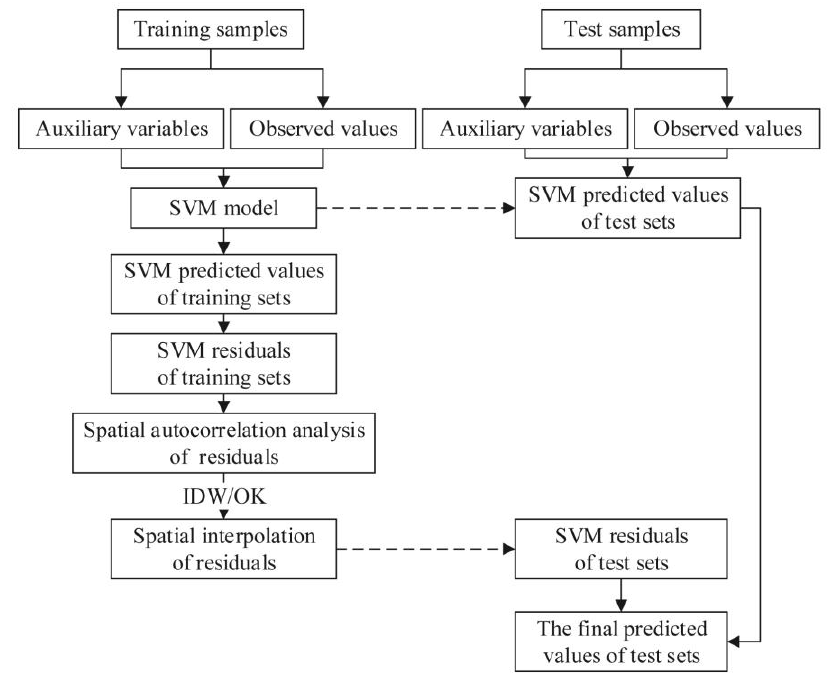
Figure 6. Flowchart of the support vector machine residual hybrid interpolation method.